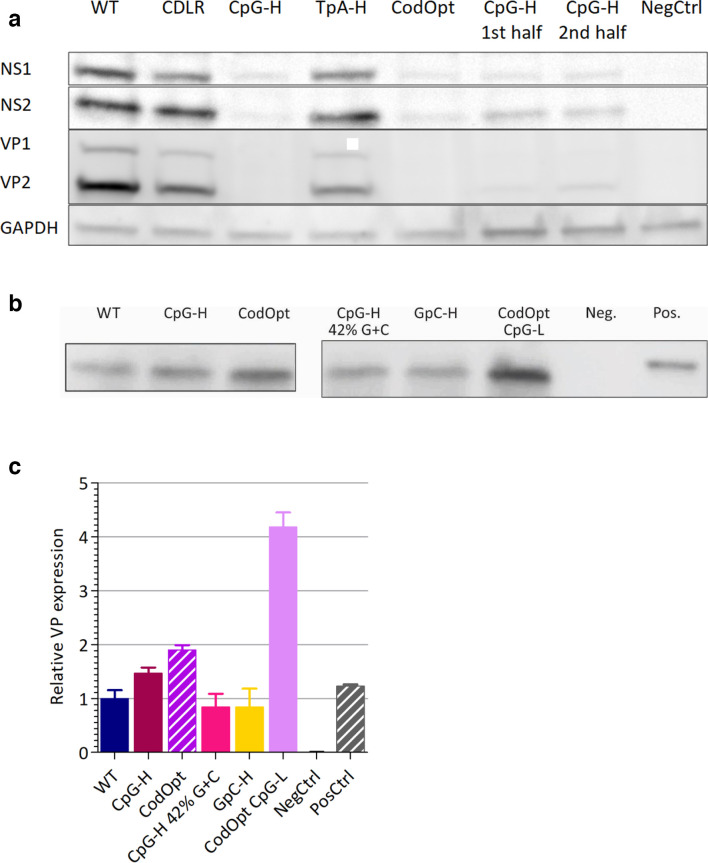
MVM gene expression and translation. (a) Viral protein expression 18 h post-infection with 1000 viral copies/cell. Uninfected cells were used as a negative control. n=3, representative image shown. (b) In vitro translation of a truncated VP2. RNA was transcribed into mRNA in vitro via a T7 promoter using the synthetic plasmids containing the different MVM inserts. Equal amounts of the RNA were then translated using an in vitro rabbit reticulocyte and measured using immunoblotting. The negative control is a mock translation with no RNA added, while the positive control is an infected cell lysate (VP2 band shown). (c) Quantification of VP2 protein levels (from Fig. 6b) by ImageJ expressed as the ratio to that of the WT gene (y-axis). Bar heights shows the mean of three replicates; error bars show +/−sem.